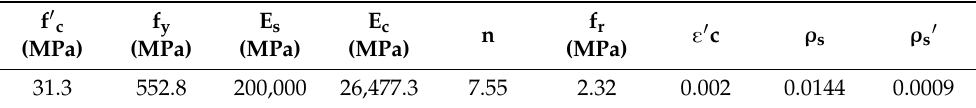
Table 7. The material parameters for Almusallam (1997) beam.